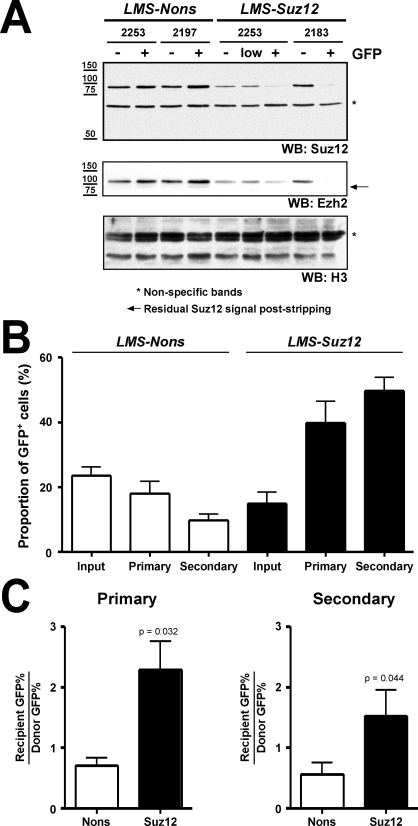
Inhibition of Suz12 by shRNA-Mediated Silencing Elevates HSC Contribution to HematopoiesisBone marrow extracted from 5-FU–treated mice was infected with either the LMS-Nons or the LMS-Suz12 virus and transplanted into recipient mice. Three independent infections were performed, and in each case, infected cells were transplanted into five recipient animals. A selection of primary recipients (9–11) were used as donors for secondary transplants, in each case these cells were transplanted into 3–5 recipient mice.(A) Thymocytes were isolated from primary recipients 12 wk after transplantation and fractionated based upon expression of GFP (+ or –); low or intermediate populations were detected in some mice (low). Protein lysates were prepared from sorted cells and Western blotting was performed to detect expression of Suz12, Ezh2, or histone H3. Nonspecific bands have been marked (*) and an arrow is used to denote residual Suz12 signal that persisted after the membrane was stripped and reprobed.(B) The frequency of cells that carried the virus (GFP+) was monitored prior to transplantation (Input) and at 8–12 wk after transplantation in primary or secondary recipients.(C) The representation of GFP+ cells was compared between donor and recipient populations and a ratio calculated (recipient GFP%/donor GFP%). Equal representation in recipient and donor populations would result in a ratio of 1.0. The representation of cells infected with LMS-Suz12 continued to increase over the course of the experiment, whereas the representation of LMS-Nons cells remained constant. Data show the mean and standard error. Statistical significance was assessed using an unpaired t-test.